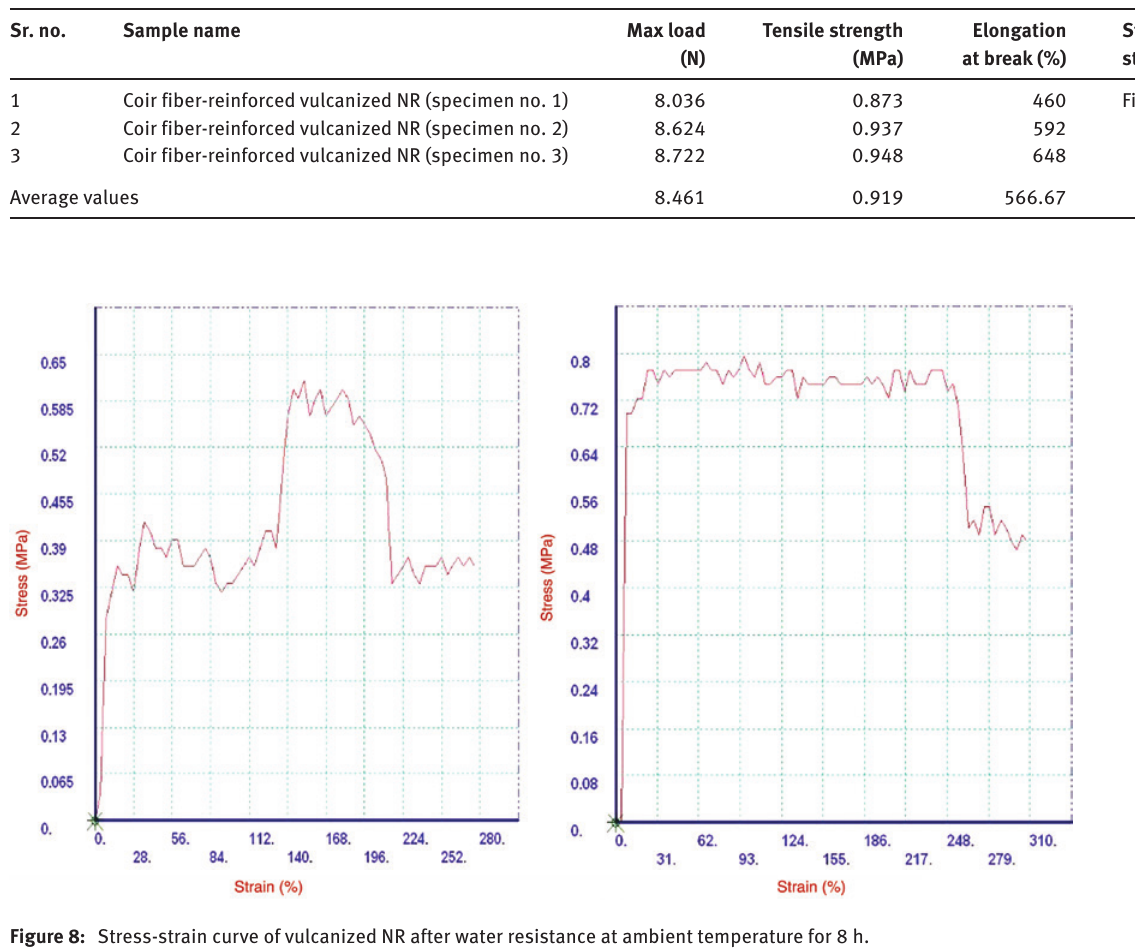
Figure 8: Stress-strain curve of vulcanized NR after water resistance at ambient temperature for 8 h.